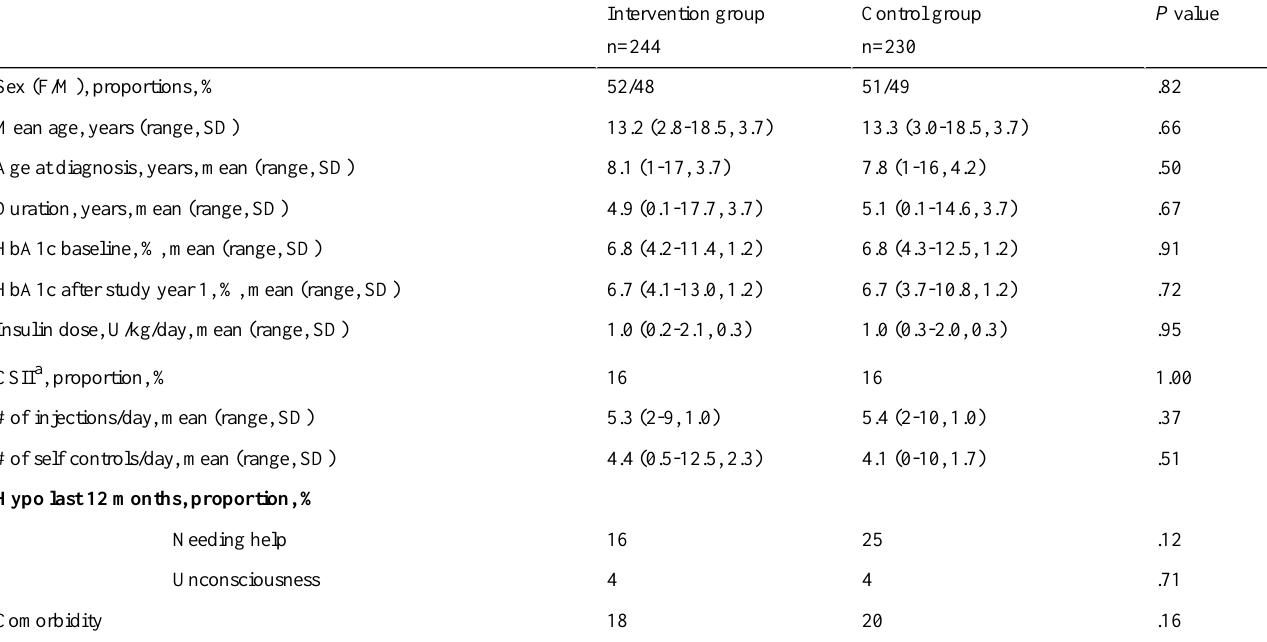
Table 1. Characteristics of the population at baseline, intervention and control group, and most recent HbA1c at baseline (2006) and after of study year 1